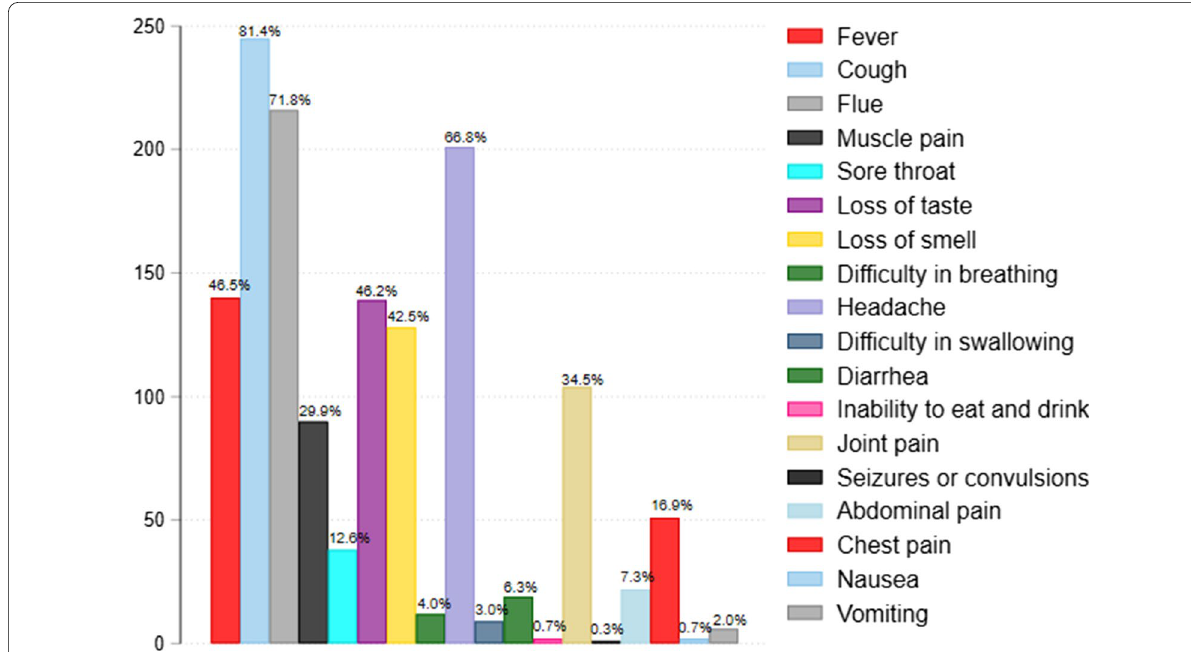
Fig. 1 Signs and symptoms experienced by COVID‑19 patients managed under home‑based care in Kapelebyong district in eastern